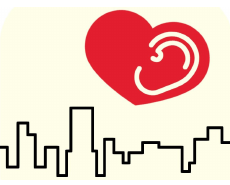
Figure 2: The Hush City app’s icon © A. Radicchi 2017